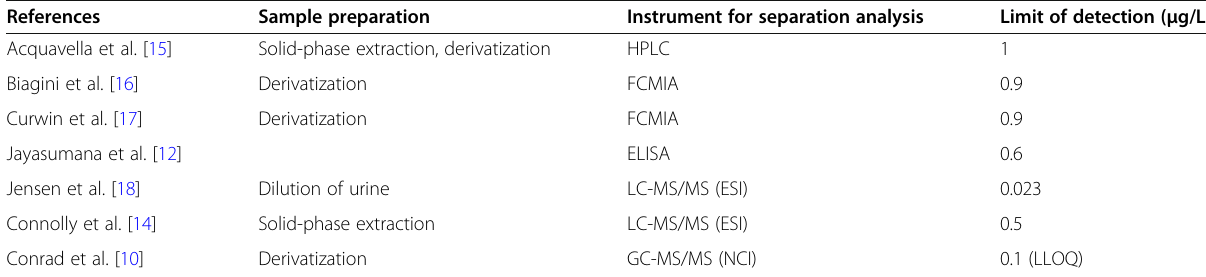
Table 1 Analytical methods for detecting glyphosate in human urine